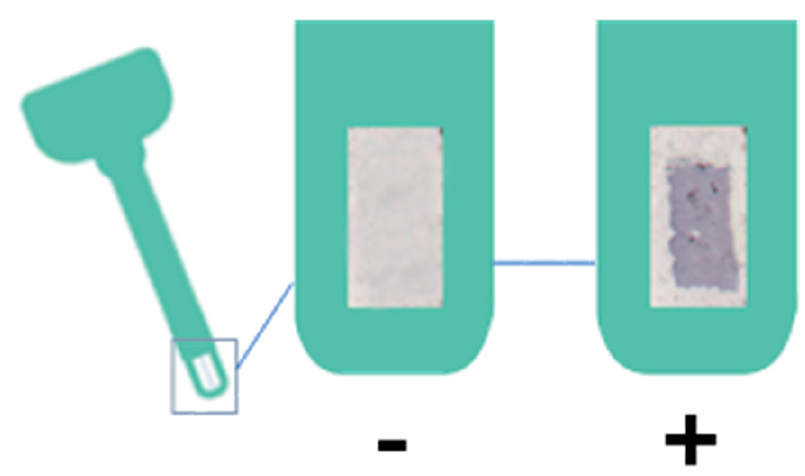
Figure 7. Negative and positive result of the haptoglobin test.